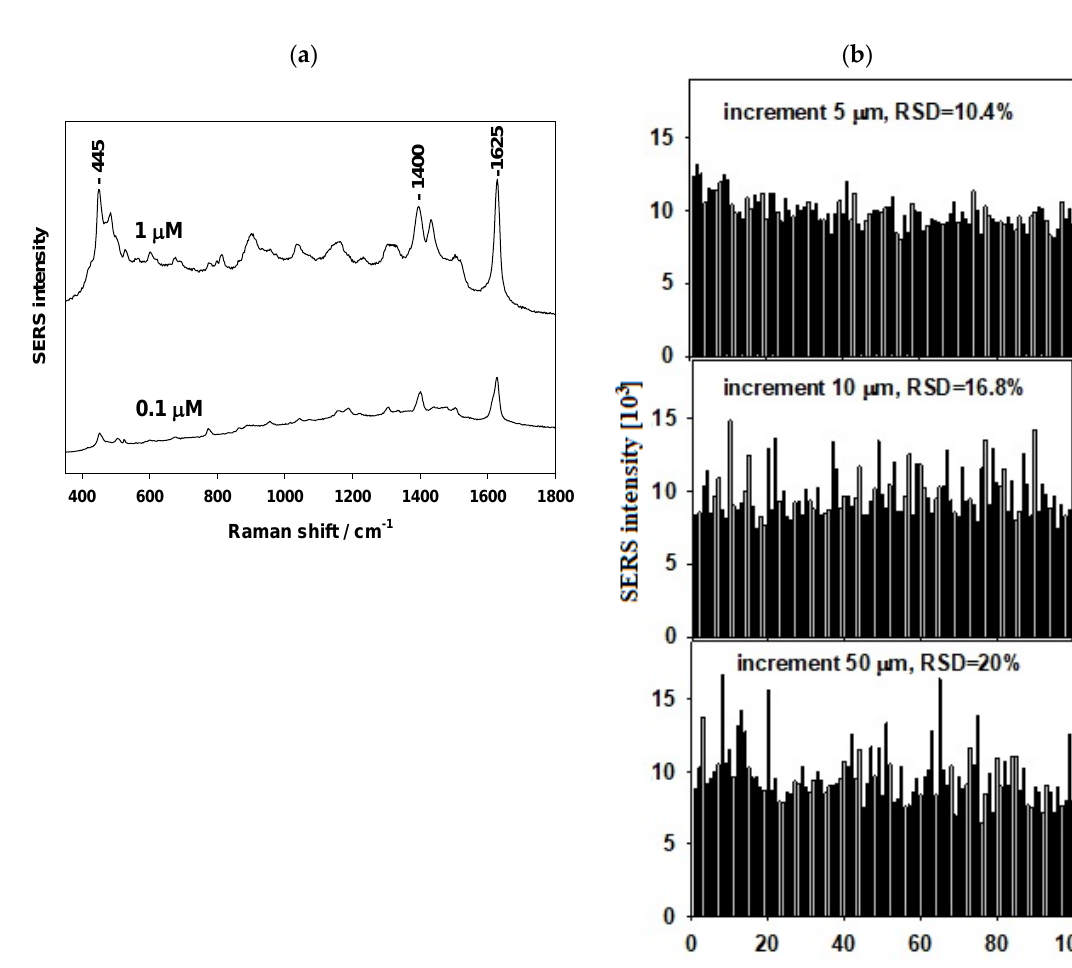
Figure 5. ( a ) SERS spectra of methylene blue and ( b ) spectral reproducibility (RSD—relative standard deviation of the signal) from 10 × 10 spectral maps of various increments.